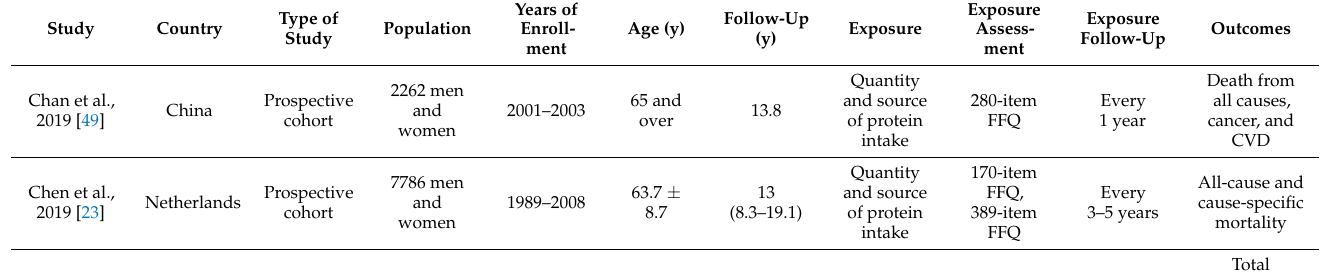
Table 2. Study characteristics and quality